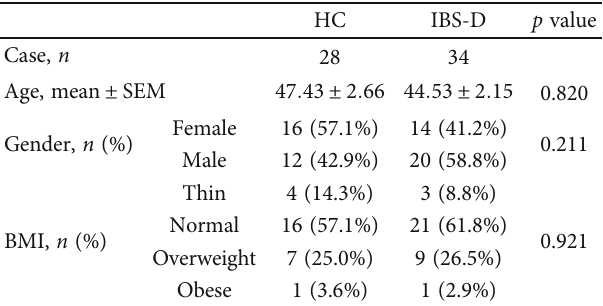
Table 1: Patient demographics.